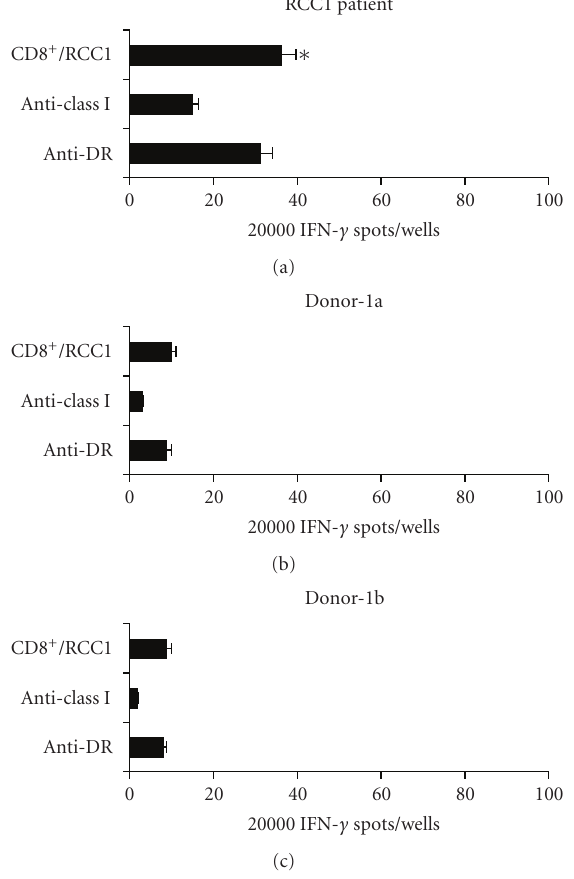
Figure 1: IFN- γ Elispot Assay CD8 + T cells isolated at day 0 . RCC1 cell line as stimulator cells and CD8 + T cells isolated from PBMC of RCC1-patient (a) and their allogeneic donor-1a (b) and donor-1b (c) at day 0 were tested in 20h IFN- γ -Elispot Assay. HLA restriction of anti-RCC reactivity was determined by adding mAbs specific for total HLA-class I and HLA-DR. Results represent the average ( ± SD) of triplicate wells and the presented data derive from 1 representative experiment of 5 performed. A paired t -test analysis was used to compare the frequencies of autologous versus allogenic specific CD8 + T cells stimulated with RCC1 cell line, after subtraction of HLA class I reactivity; P < . 03 was considered statistically significant ( ∗